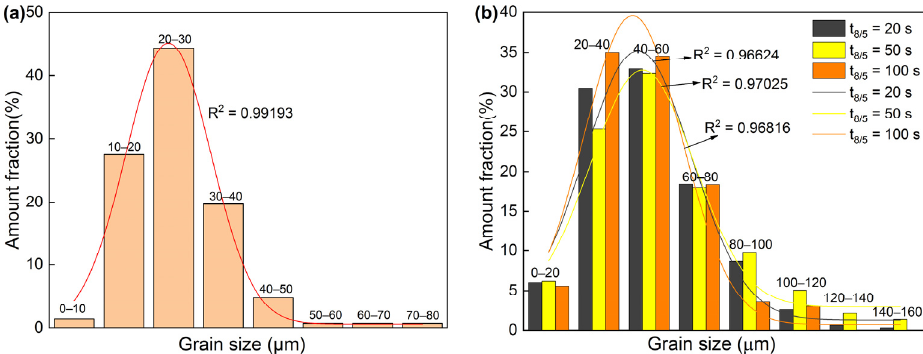
Figure 4. TP = 1200 °C. Grain morphology at different t 8/5 time: ( a ) Original, ( b ) 20 s, ( c ) 50 s, ( d ) 100 s.